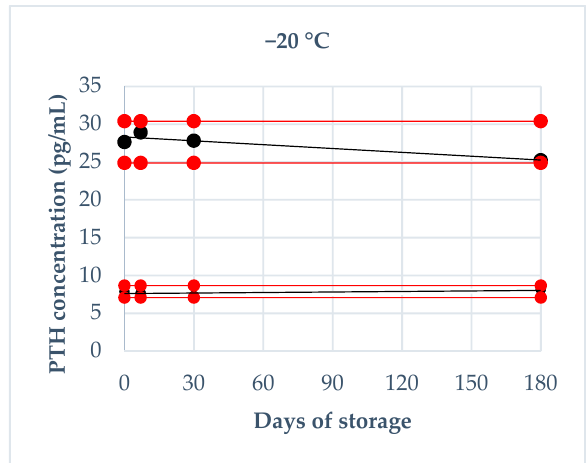
Figure 3. PTH stability at 4 °C during 72 h of storage (24 h, 48 h, 72 h): the black lines indicate the tendency of the obtained values; the red lines indicate ± 10% from the baseline value.